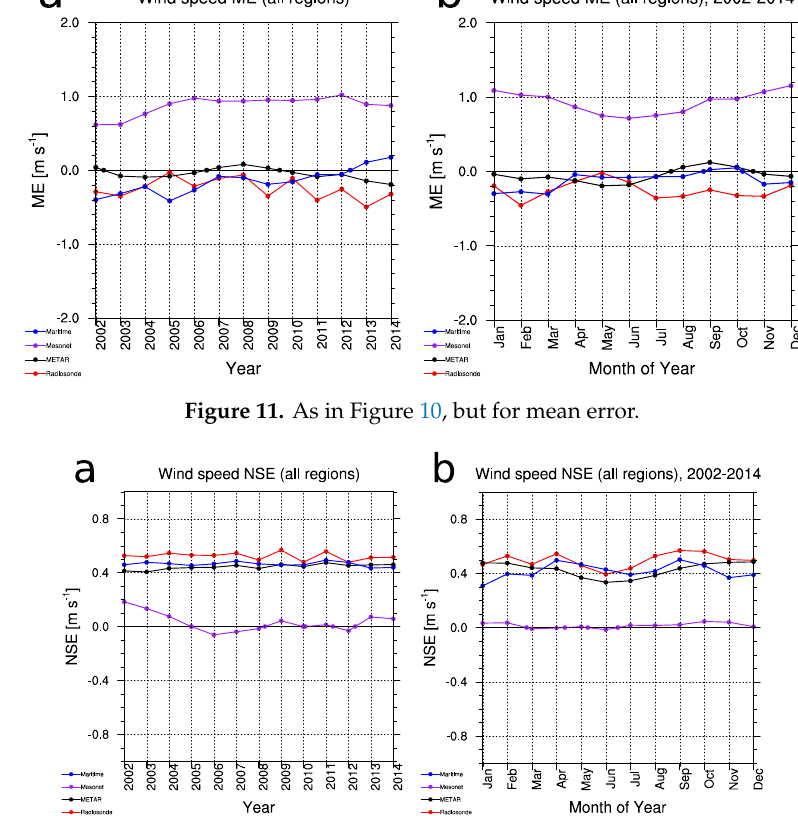
Figure 12. As in Figure 10, but for Nash–Sutcliffe efficiency.